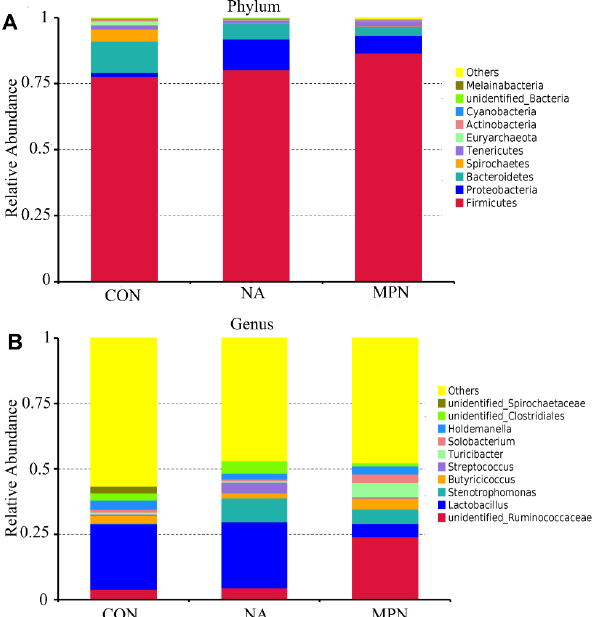
Figure 5. Effect of niacin on colonic microbial communities in weaned piglets. The relative composition of the most abundant 10 species in the colonic contents at the phylum ( A ) and genus ( B ) levels in the different groups. CON, control group; NA, niacin group; MPN, GPR109A antagonist group.